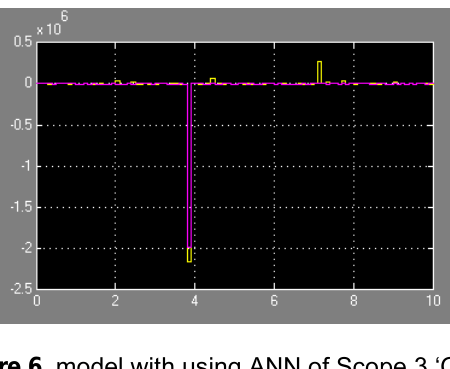
Figure 8. model with using ANN of Scope 3 ‘G 3 (u)’